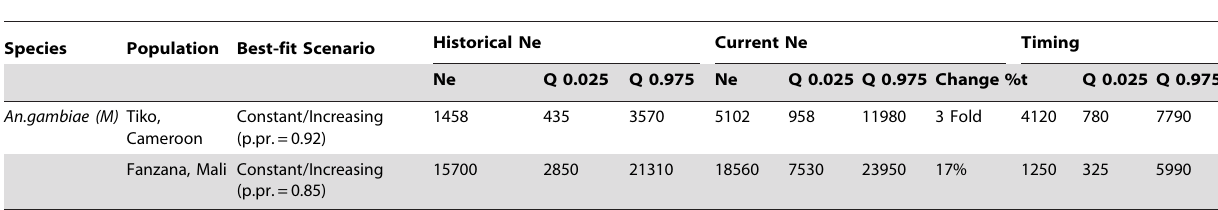
Table 5. Results from ABC analysis for the two negative control populations—showing best-fit scenario, historical N e (with 0.025 and 0.975 quantiles), recent N e (with quantiles), and the timing of a population change (generations before present), t (with quantiles), and percentage change in N e . Medians are reported for all estimates.